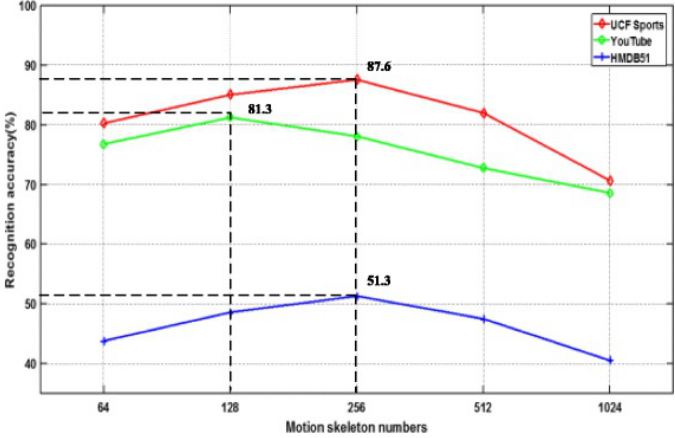
Fig. 7 Comparison of motion trajectories in a single direction between a single identification point.